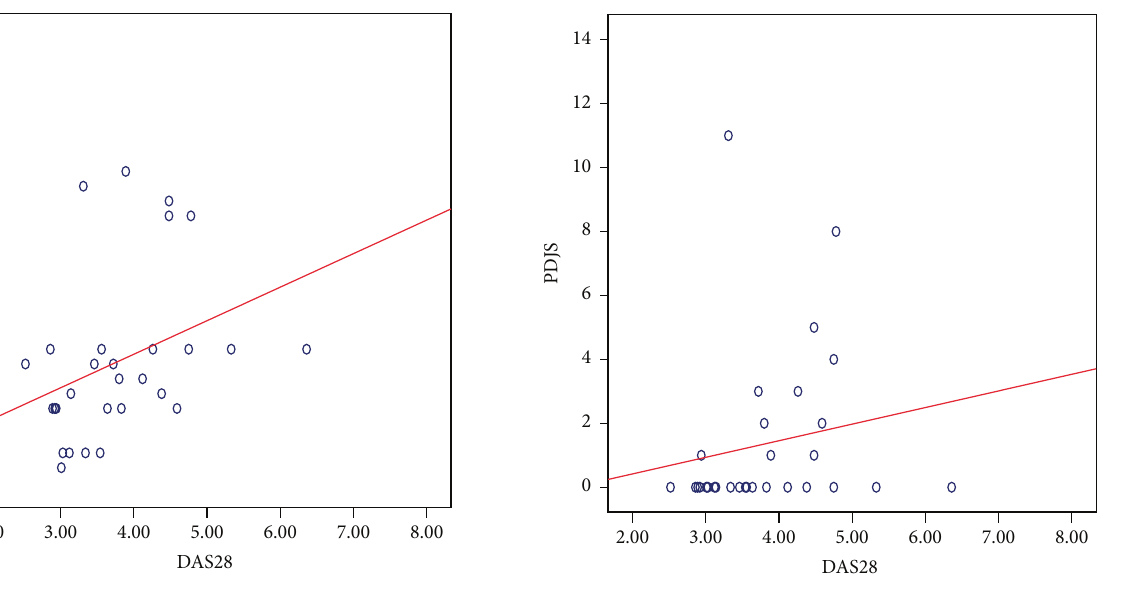
Figure 7: Relation between PDJS (taken from 28 MCP, PIP, and DIP joints)andDAS28scorein30patientswithPsA.Spearman’s 𝜌 :0.367; 𝑃 : 0.046 suggesting a significant correlation.